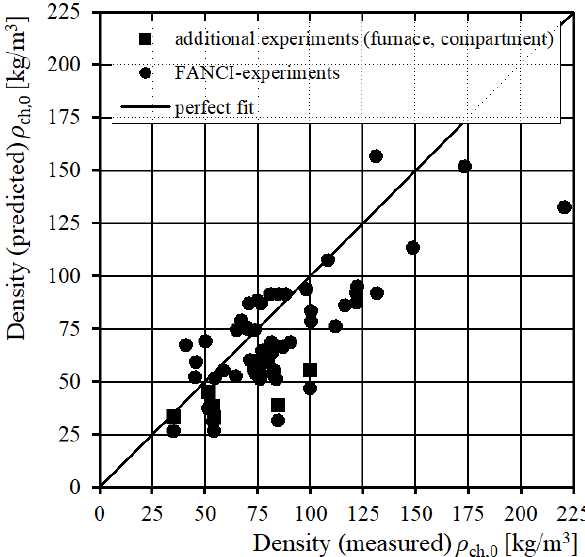
Figure 10: Measured vs. predicted char layer